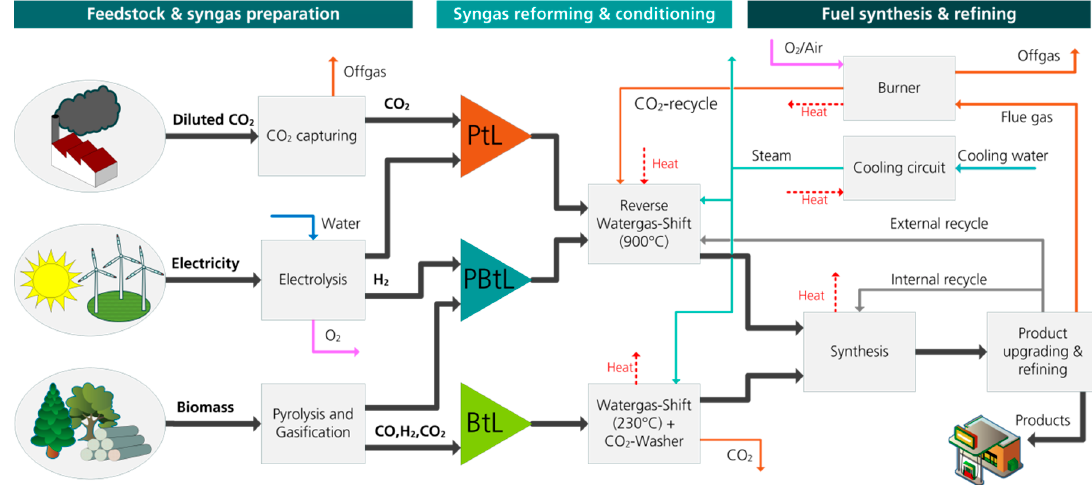
Figure 1. Simplified presentation of the Fischer–Tropsch process routes investigated, reproduced with permission from [11].